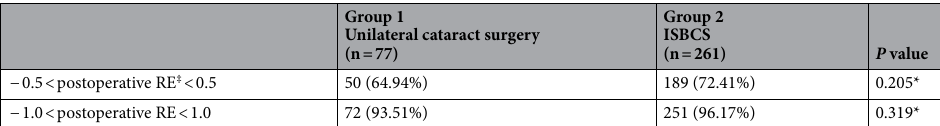
Table 3. Distribution of patients with postoperative refractive error in the two groups. ISBCS, immediate sequential bilateral cataract surgery; RE, refractive error. *Pearson’s Chi-square test. ‡ Refractive error (postoperative spherical equivalent − intraocular lens target in diopters).